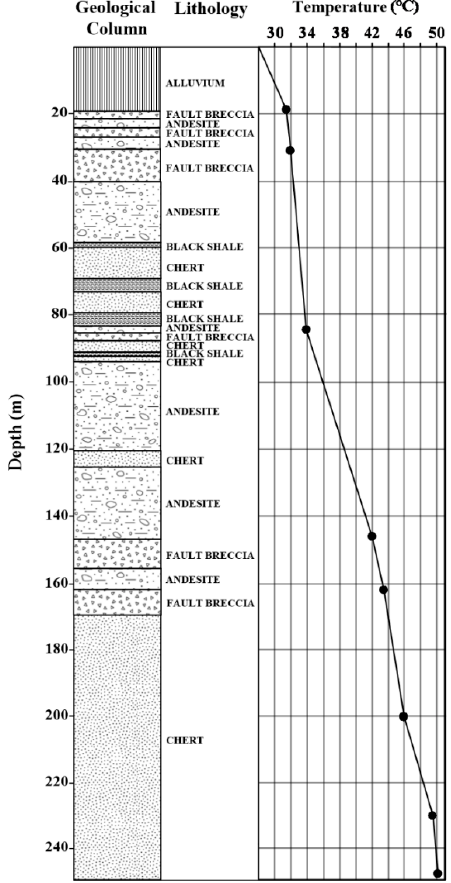
Figure 2. Lithological log and temperature gradient in a drilled core from the Magumsan thermal area [1].